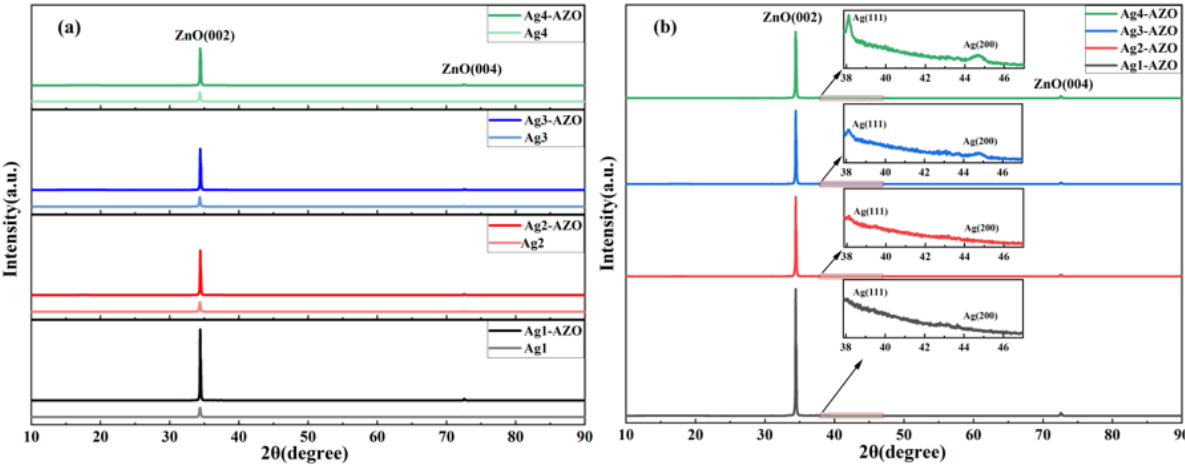
Figure 1. ( a ) Comparison of XRD patterns of the films before and after the growth of AZO NRs; ( b ) XRD patterns of all the Ag NWs/AZO NRs composite